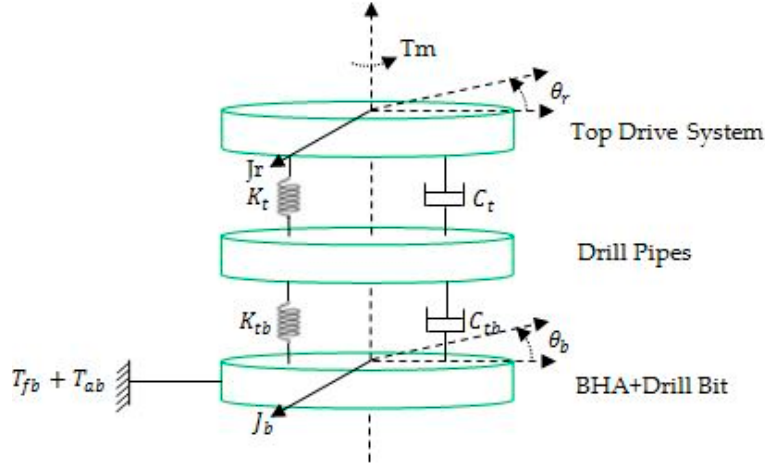
Figure 3. Three elements proxy model of rotary drilling